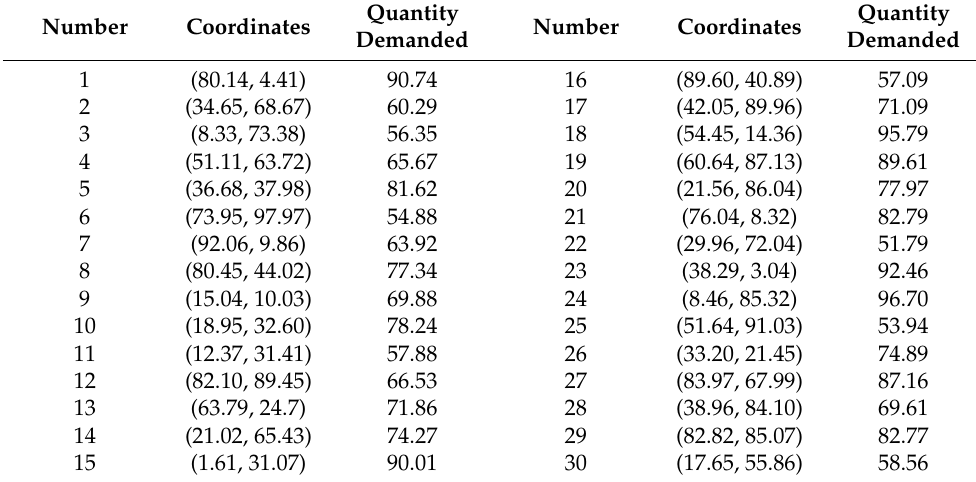
Table 4. Demand point information.